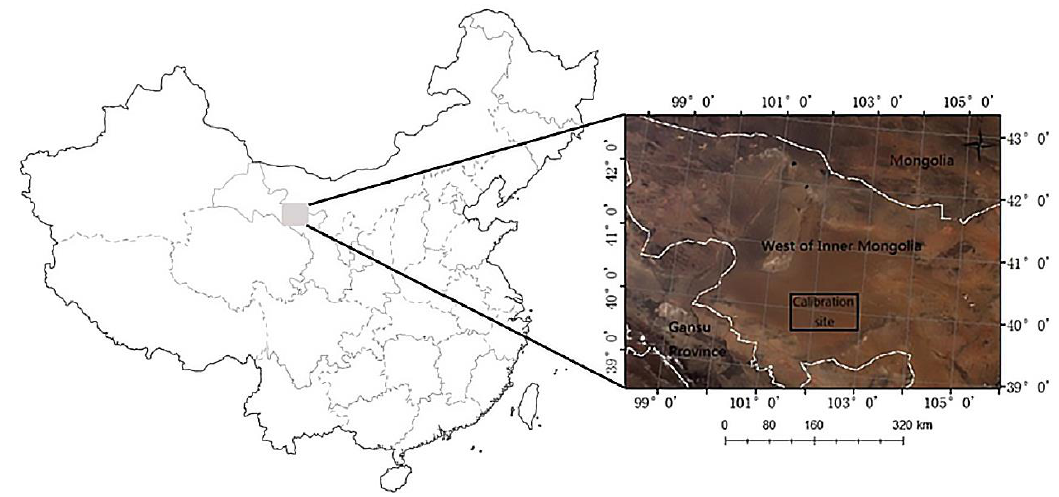
Figure 1. Location of the calibration site and a true color composite from Moderate Resolution Imaging Spectroradiometer (MODIS) imagery.